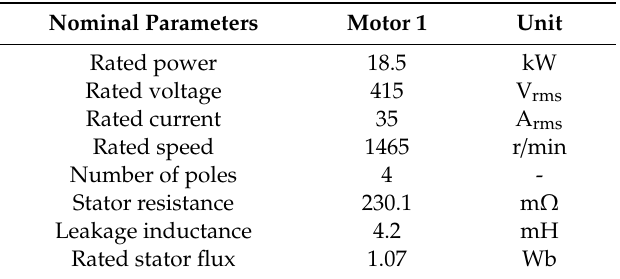
Table 1. Manufacturer Data for Induction Motor used in the